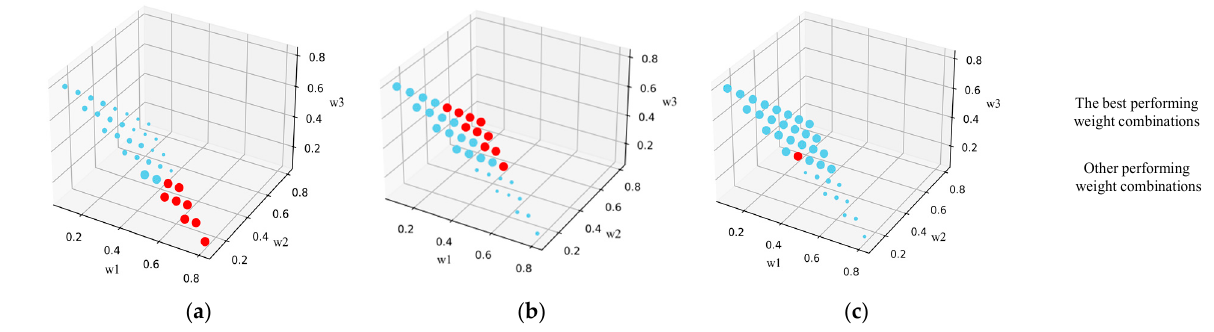
Figure 13. The actual layout of round-trip public air routes.